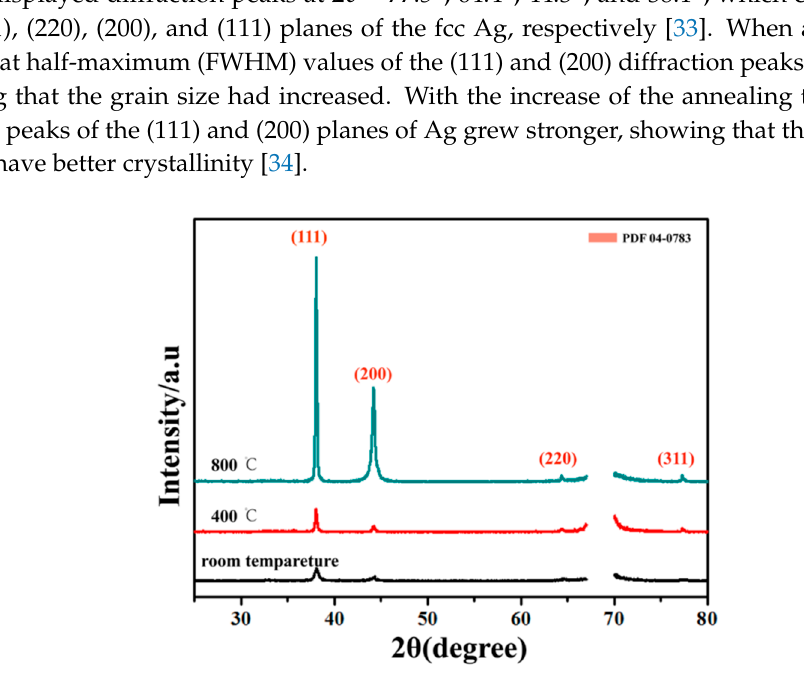
Figure 3. XRD patterns of the SiO 2 /Ag/SiO 2 nanocap arrays at different temperatures.